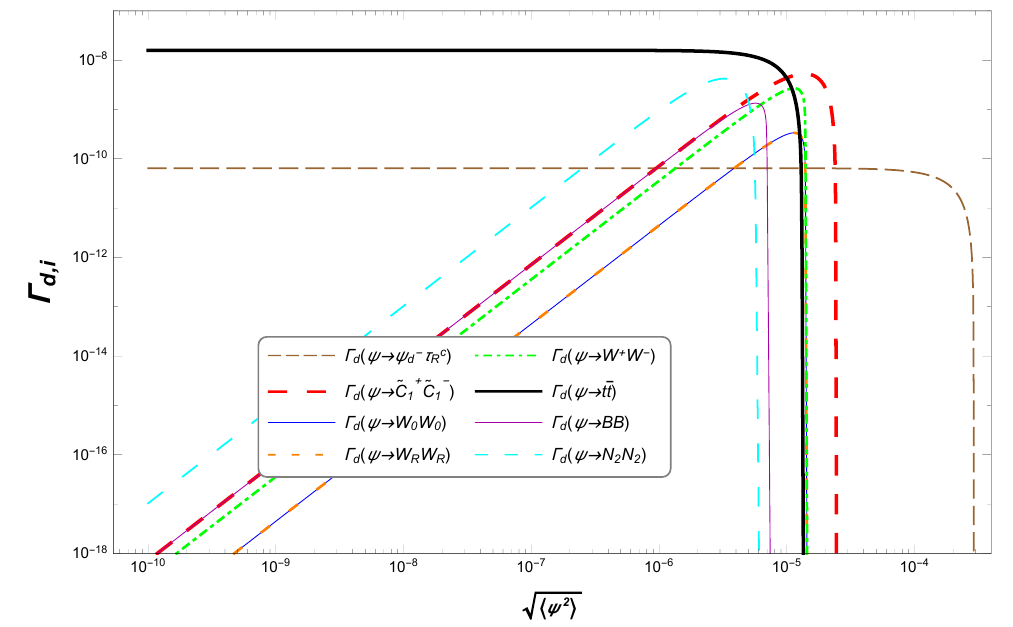
p h 2 i . The Yukawa p h 2 i will decrease with